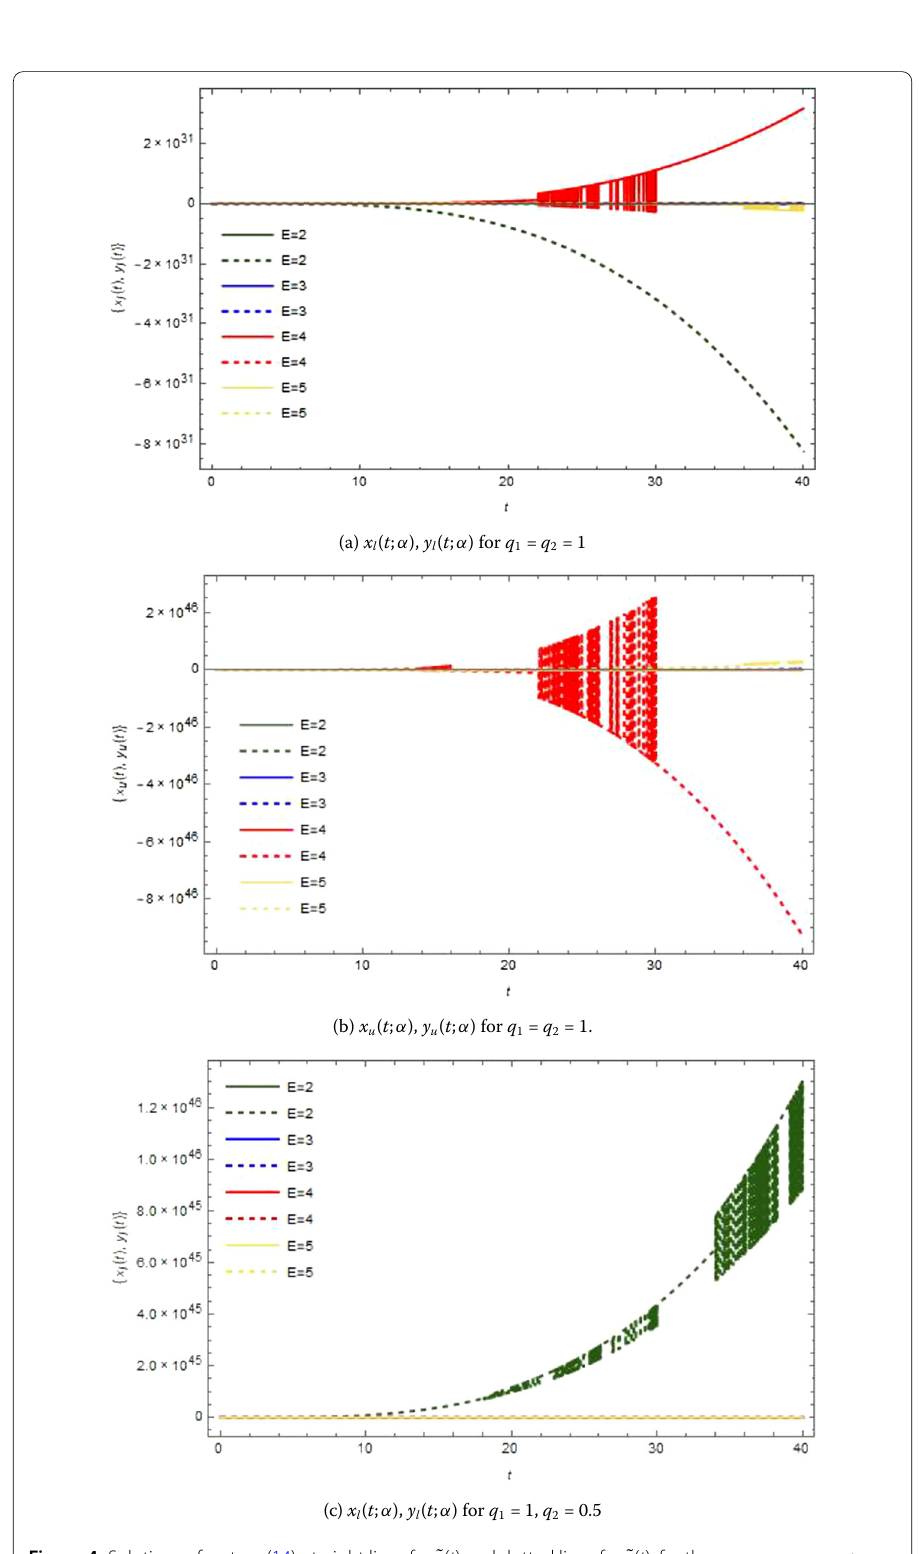
Figure 4 Solutions of system (14), straight lines for ˜ x ( t ) and dotted lines for ˜ y ( t ), for the cases q 1 = q 2 , q 1 > q 2 and q 1 < q 2 at α = 0.98, σ = 0.998 and for different values of